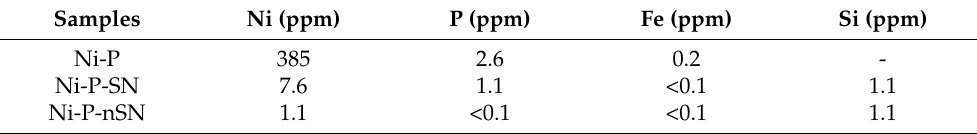
Figure 9. EDS analysis data of corroded surface (region I) and original surface (region II) of ( a , b ) Ni-P, ( c , d ) Ni-P-SN, and ( e , f ) Ni-P-nSN specimens collected from the marked rectangular area shown in Figure 8a–c, respectively. The inset of each figure shows the quantitative elemental composition. Table 2. ICP-MS analysis results of the corrosion